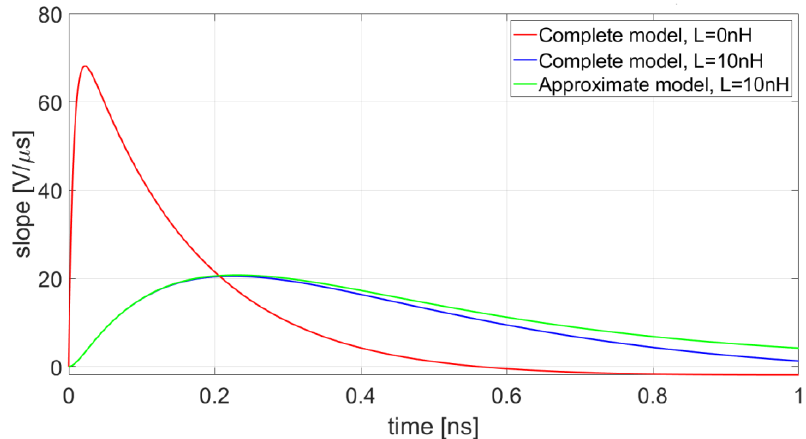
Figure 6. Time derivatives of the response V out (t): comparison between the complete model in Equation (9) and its approximation in Equation (11).